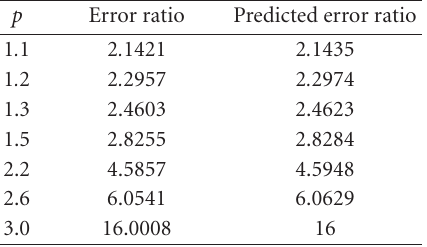
(cid:21) Table 3.6. Approximation of 1 on W k ,1 -surfaces, precision 4 quadrature. p Error ratio Predicted error